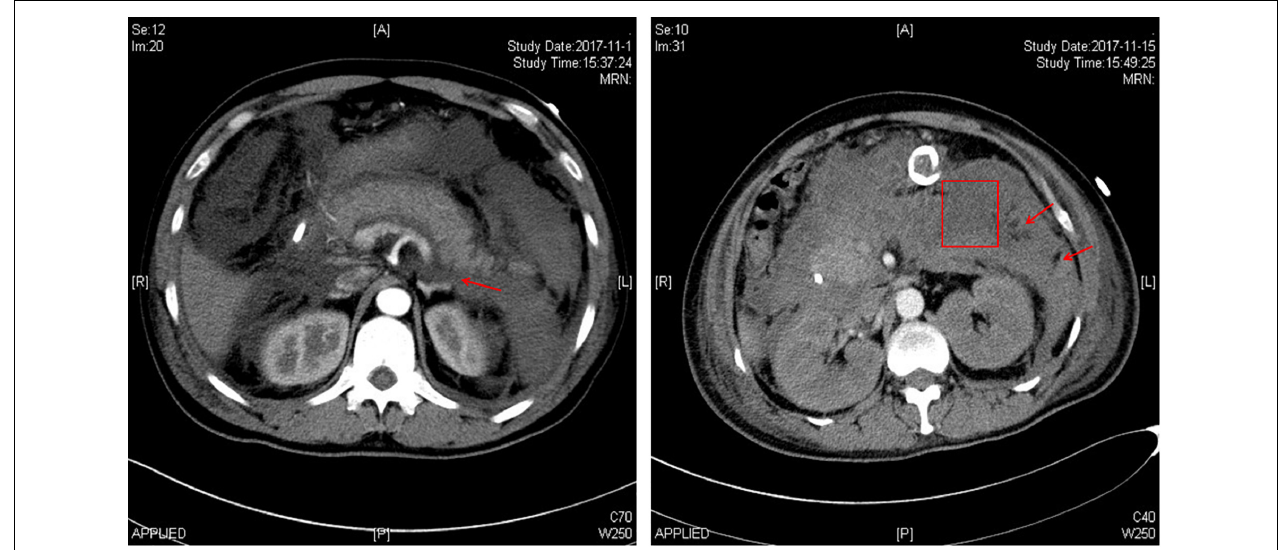
FIGURE 2 | Abdominal computed tomography images of the patient showing the affected pancreas. The left image was taken on the third day of onset of acute pancreatitis, showing peripancreatic exudation (arrow) and the enlarged pancreas with adjacent water density shadow. The right image was taken on the eighteenth day of disease onset, showing the occurrence of infected pancreatic necrosis. The box indicates a partial necrotic pancreas whilst the arrows indicate infective